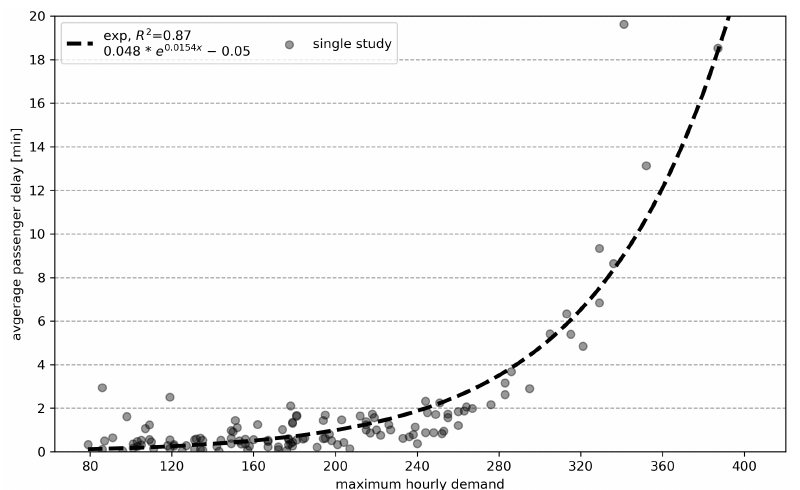
Figure A2. Refined analysis of the effect of peak-hour demand on the average passenger delay (excluding all scenarios surpassing the PICAP